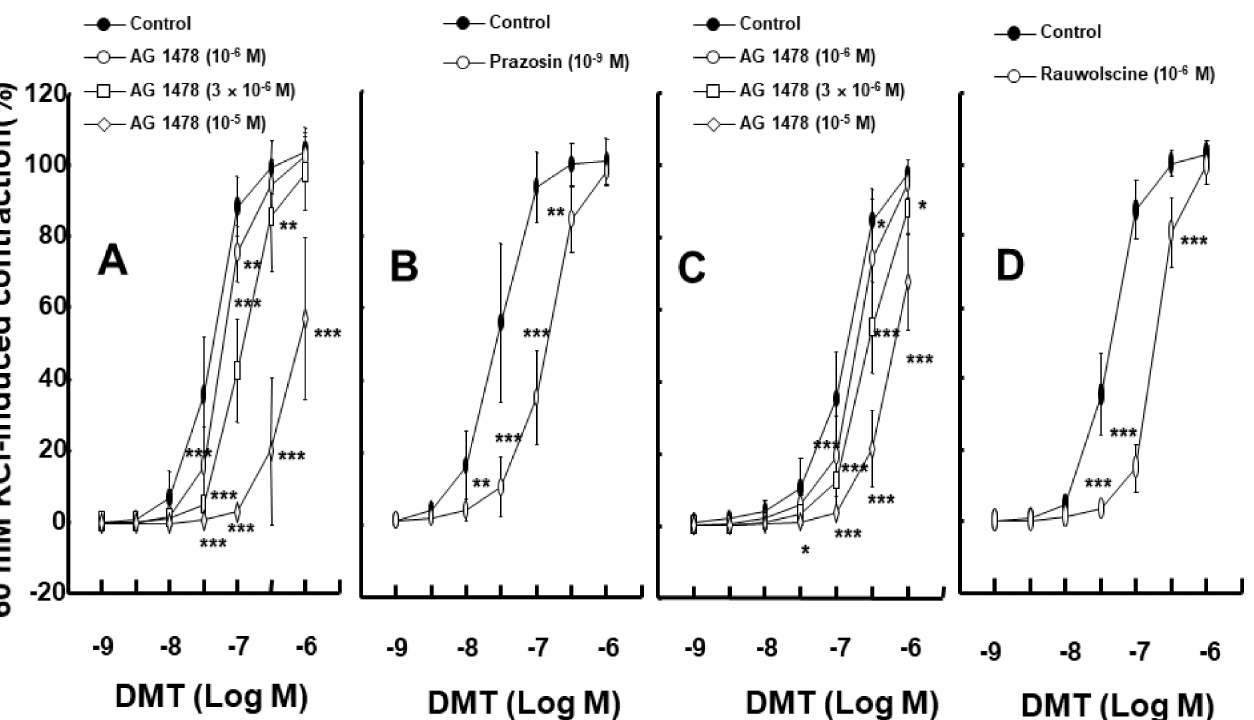
Figure 1. ( A , B ): Effects of AG1478 (( A ) N = 8, 6, 5, and 6 for control, 10 − 6 , 3 × 10 − 6 , and 10 − 5 M, respectively) and prazosin (( B ) N = 5) on dexmedetomidine (DMT)-induced contraction in isolated endothelium-denuded rat aortas. ( C ): Effect of AG1478 (N = 5) on DMT-induced contraction in isolated endothelium-denuded rat aortas pretreated with prazosin (10 − 9 M). ( D ): Effect of rauwolscine (10 − 6 M, N = 5) on DMT-induced contraction in isolated endothelium-denuded rat aortas. Data are shown as mean ± SD and are expressed as a percentage of isotonic 60 mM KCl-induced contraction. N indicates the number of rats. Control indicates no treatment. * p < 0.05, ** p < 0.01, and *** p < 0.001 versus